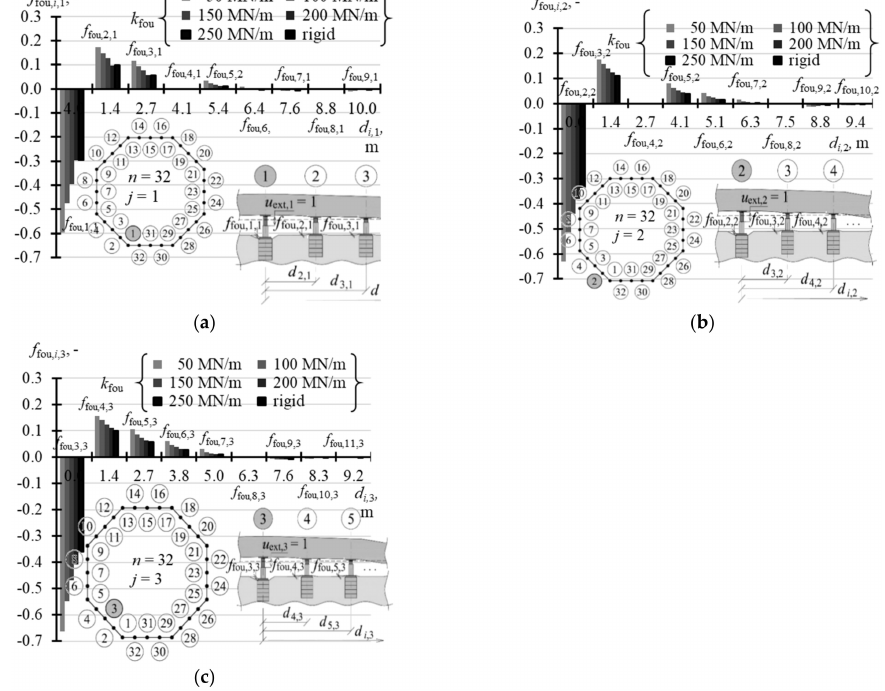
Figure 23. Elements of the matrix f fou of support displacements for different stiffness values k fou of the jack support when n = 32: ( a ) elements f fou ,i, 1 ; ( b ) elements f fou ,i, 2 ; ( c ) elements f fou ,i, 3